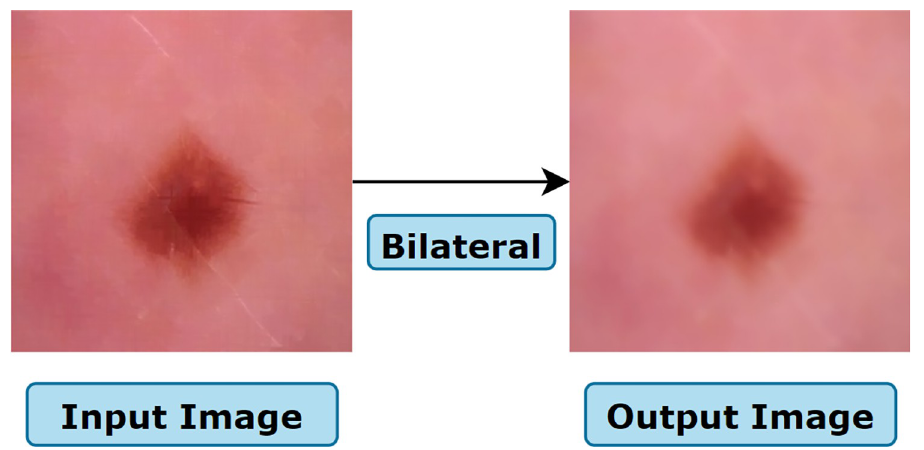
Fig 17. Resultant image after applying the bilateral